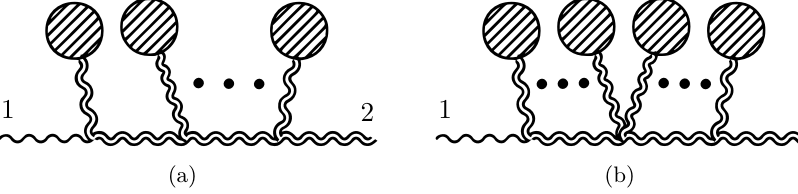
Figure 3 . The diagrams without hard propagators. The blob represents the soft background.